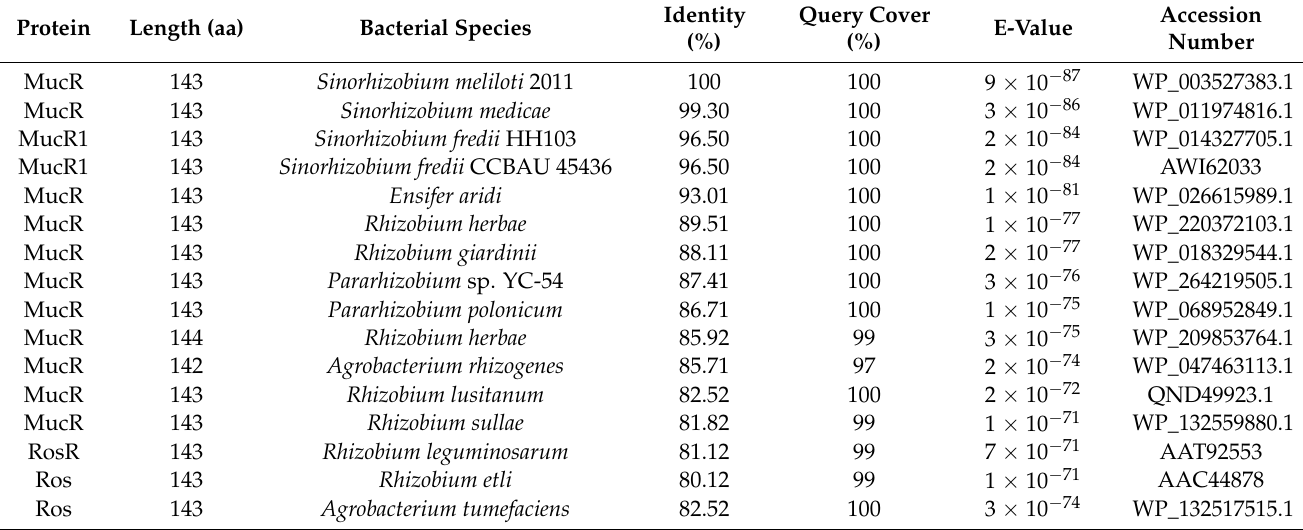
Table 1. MucR/Ros homologs from different representatives of Rhizobiaceae